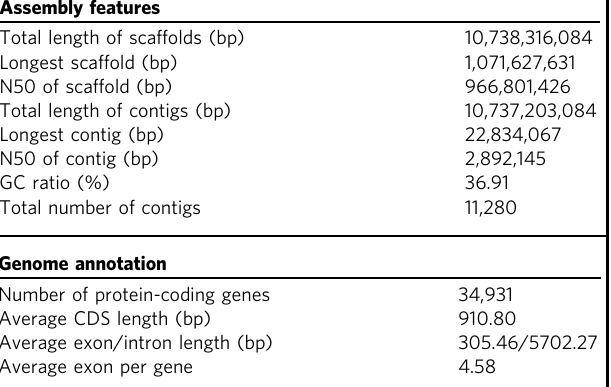
Table 1 Assembly and annotation statistics of the draft genome of T. yunnanensis